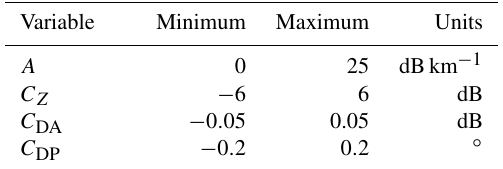
Table 3. Ranges of values for differential evolution (DE) used in the self-consistency method.